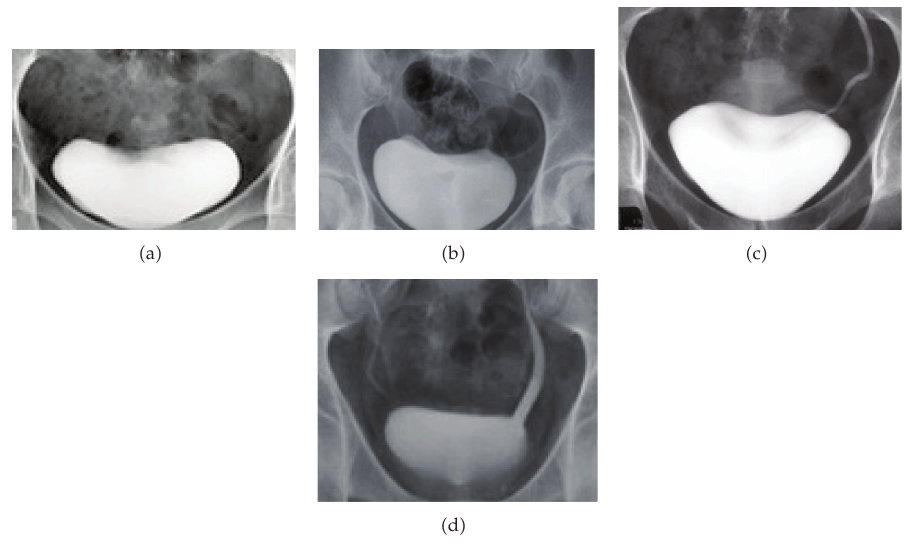
Figure 2: Shapes of di ff erent bladders later on during micturition, taken by a Voiding Cystourethrogram (cid:5) a (cid:6) (cid:3) 2 (cid:4) , (cid:5) b (cid:6) (cid:3) 3 (cid:4) , (cid:5) c (cid:6) (cid:3) 2 (cid:4) , (cid:5) d (cid:6) (cid:3) 9 (cid:4) . The light patch in the middle is the bladder. Also visible are the bones, and, in some instances such as (cid:5) c (cid:6) and (cid:5) d (cid:6) , we can see the right